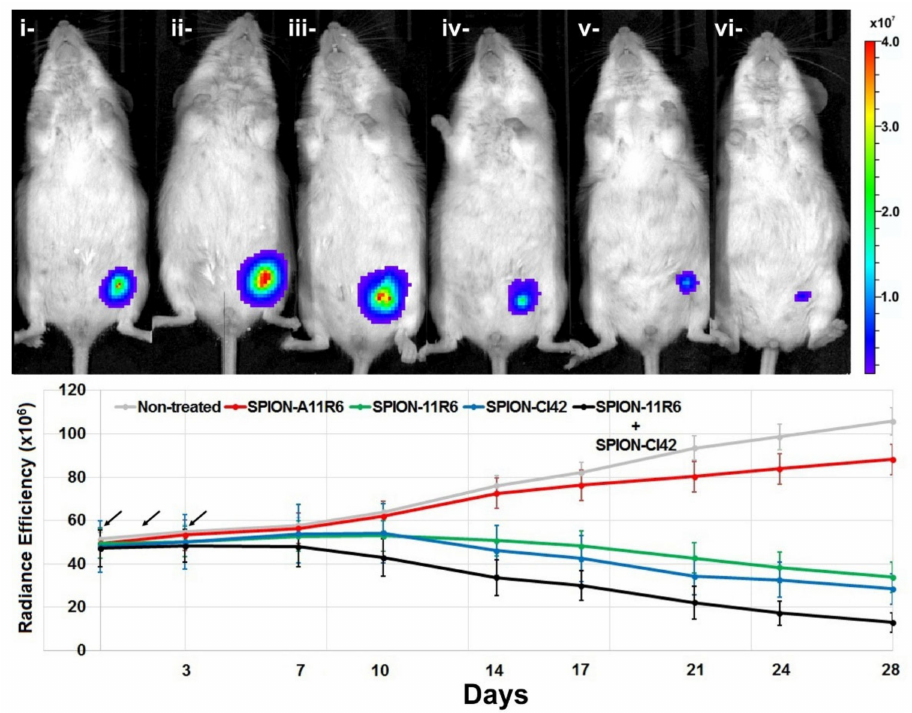
Figure 4. In vivo aptamer-conjugated SPIO nanoparticles therapeutic e ffi cacy assessed using noninvasive BLI. Representative bioluminescence images (upper row) and corresponding quantitative assessments of radiance e ffi ciency (lower row) in 4T1 tumor-bearing mice. Noninvasive imaging protocols were performed pre- ( t = 0; corresponding to three-weeks post-tumor cell inoculation in the mammary fat pad) and up to 28 days post-injection of three consecutive doses (24 h interval time) of di ff erent aptamer therapeutic formulations. Black arrows highlight the injection time